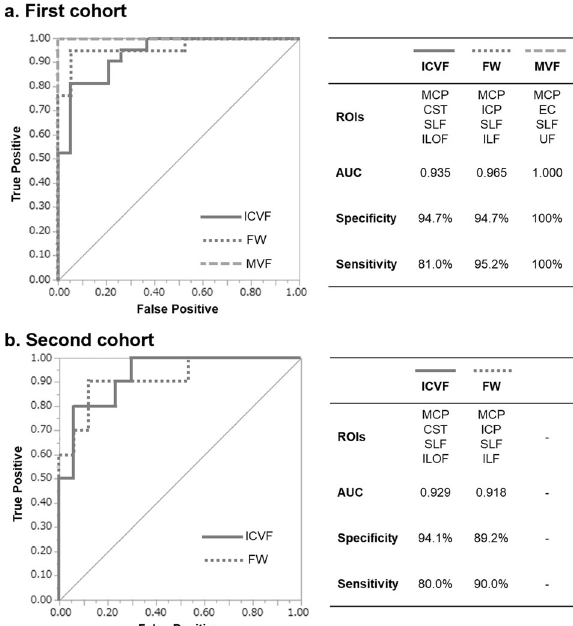
Fig. 5 ROC curve for distinguishing MSA-P from PD. a In the fi rst cohort, the AUC for ICVF was 0.935 (speci fi city 94.7%, sensitivity 81.0%) using the four regions of MCP, CST, SLF, and ILOF. The AUC for FW was 0.965 (speci fi city 94.7%, sensitivity 95.2%) using the MCP, ICP, SLF, and ILF. The AUC for MVF was 1.000 (Speci fi city 100%, Sensitivity 100%) when using MCP, EC, SLF, and UF. b Similar AUCs for ICVF and FW were also found for the second cohort (Supplementary Table 5). CST corticospinal tract, EC external capsule, FW free water, ICP inferior cerebellar peduncle, ICVF intracellular volume fraction, ILF inferior longitudinal fasciculus, ILOF inferior fronto-occipital fasciculus, MCP middle cerebellar peduncle, MVF myelin volume fraction, SLF superior longitudinal